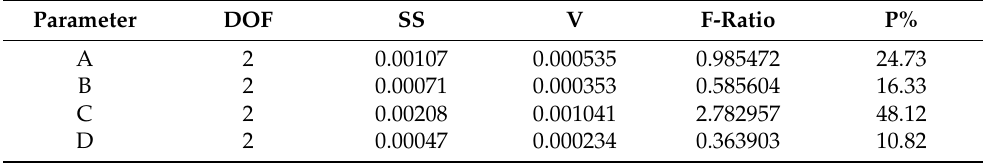
Table 9. ANOVA results for warpage.